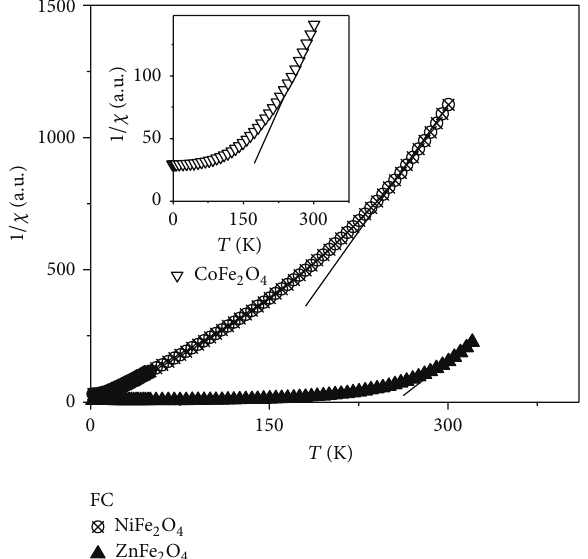
Figure 6: Temperature dependences of reciprocal susceptibility 𝜒 −1 (𝑇) for the NPs of zinc, cobalt, and nickel spinel ferrites.